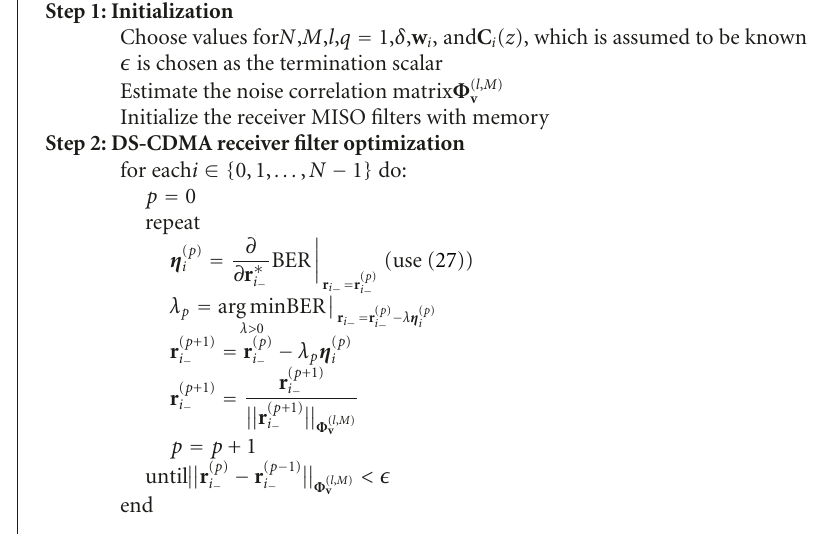
Algorithm 1: Pseudocode of the numerical optimization algorithm.